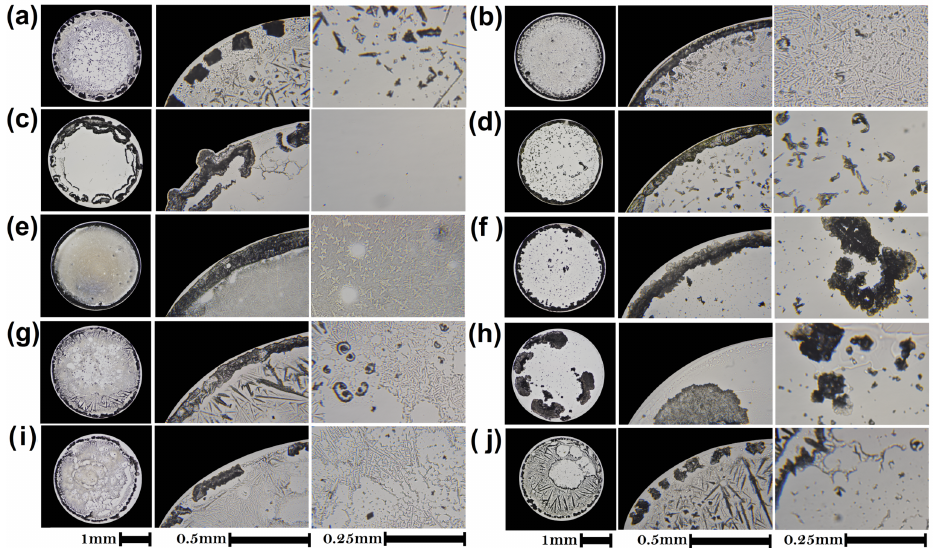
Figure 8. Patterns in dried droplets of 10 medicines. Dried droplets of ( a ) Pantoprazole/NaCl, ( b ) Fluconazole/NaCl ( c ) Clindamycin/NaCl, ( d ) Nitrofurantoin/NaCl, ( e ) Cefaclor/NaCl, ( f ) Metronidazole-Diiodohydroxyquinoline/NaCl, ( g ) Meloxicam-Methocarbamol/NaCl, and ( h ) Naproxen-Carisoprodol/NaCl. Deposits of Indomethacin-betamethasone-methocarbamol/NaCl of two different manufacturers ( i ) m 1 and ( j ) m 2 ,